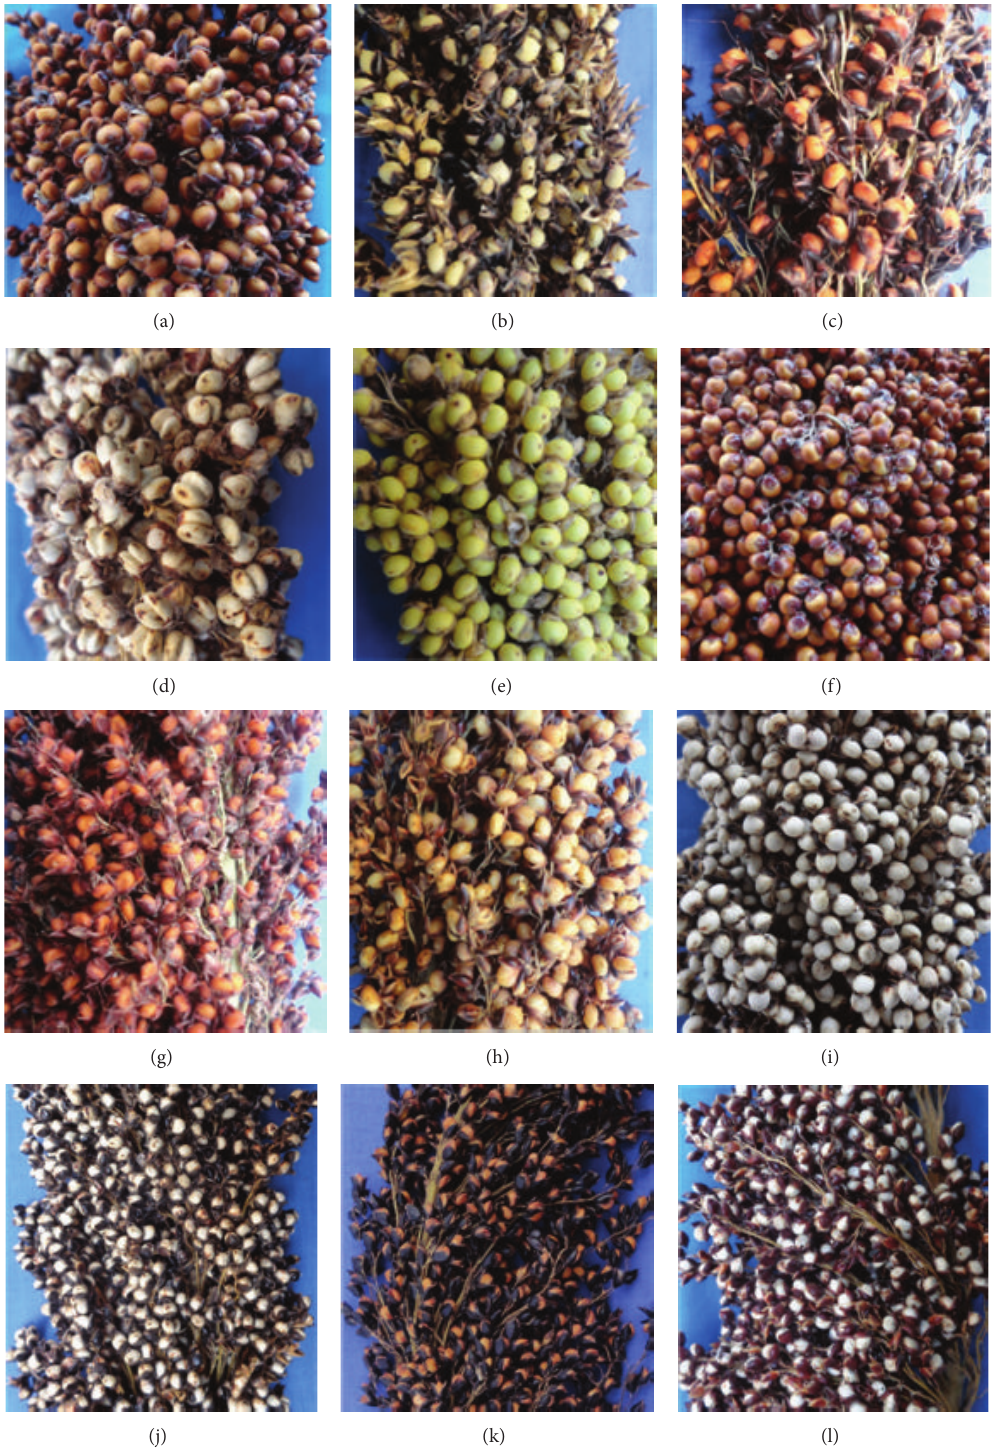
Figure 1: Morphological variability of grain colour, glume colour and hairiness, number of grain per glume, panicle compactness and grain covering within evaluated accessions (a) red grain, purple glume, absence of hairiness, semi-compact panicle; (b) white grain, black glume, semi-loose panicle; (c) red grain, black glume, loose panicle; (d) white grain, black glume, high hairiness, semi compact panicle, two grains per glume; (e) yellow grain, beige glume, medium hairiness, compact panicle; (f) orange grain, red glume, compact panicle; (g) red grain, red glume, 75% of grain covered, loose panicle; (h) red grain, purple glume, 50% of grain covered, semi loose panicle; (i) white grain, black glume, medium hairiness, compact panicle; (j) white grain, black glume, low hairiness, loose panicle; (k) red grain, black glume, 100% of grain covered, loose panicle; (l) white grain, purple glume, 75% of grain covered, loose